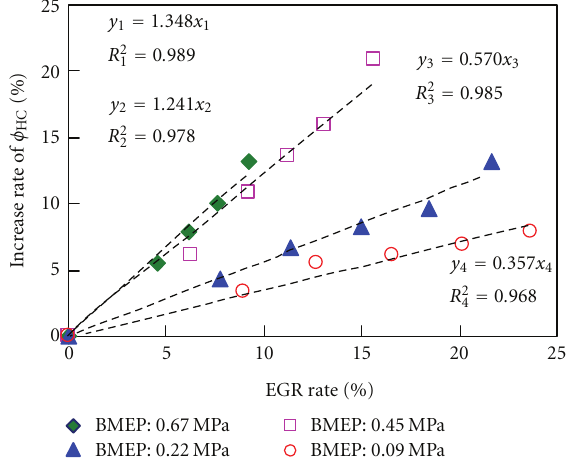
Figure 11: The HC volumetric concentration increasing feature with EGR